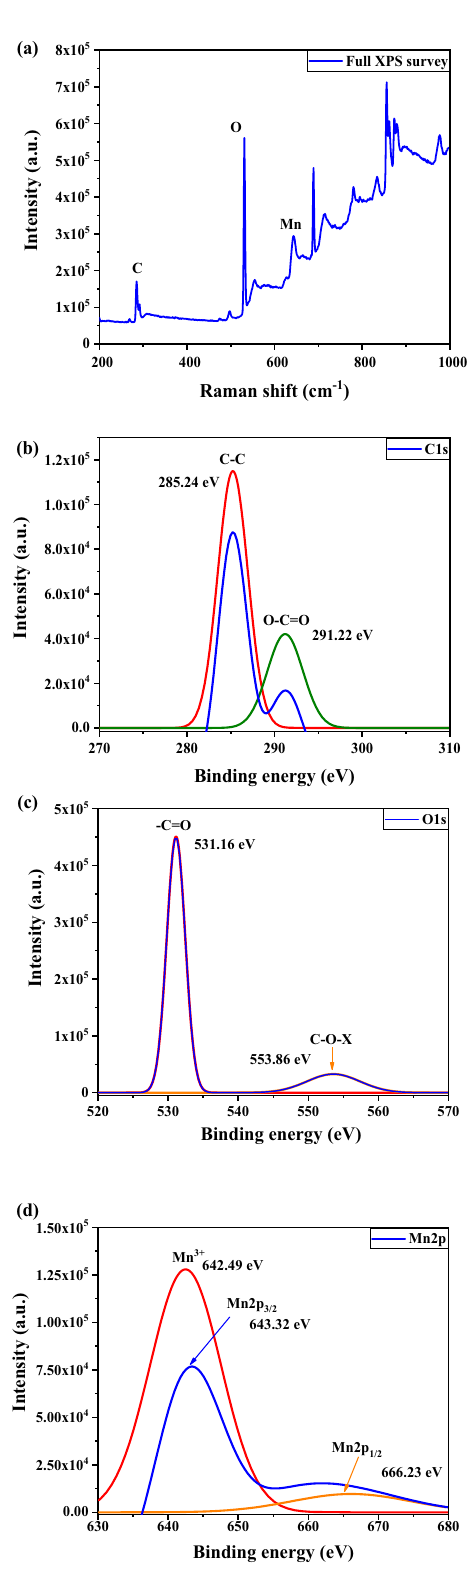
Figure 7. Survey XPS spectrum ( a ) and high-resolution XPS spectra of ( b ) C1s, ( c ) O1s, ( d )